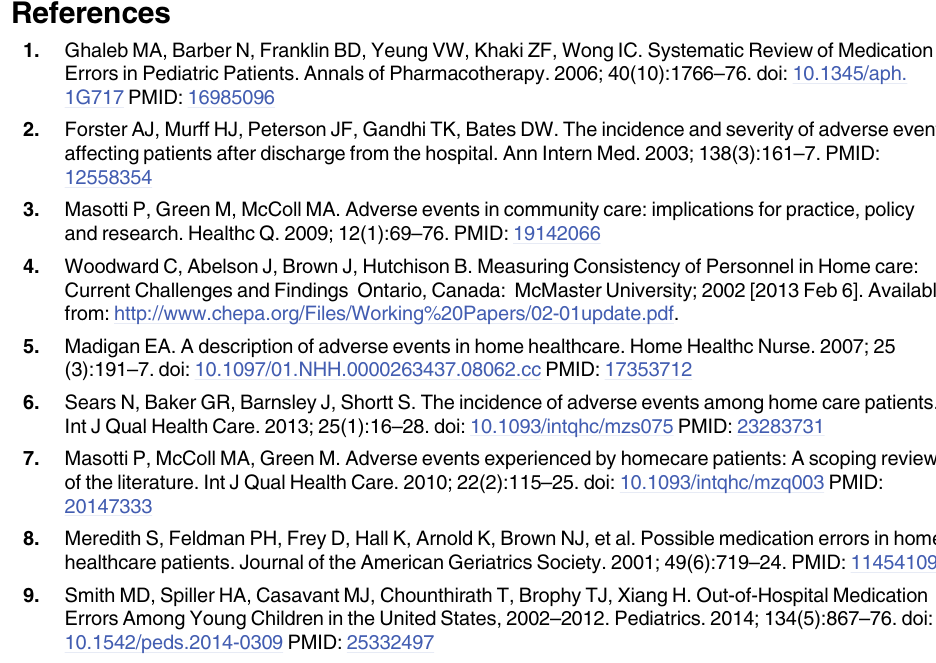
S4 Table. Inclusion/Exclusion Criteria (DOCX) S5 Table. Quality Assessment Scores